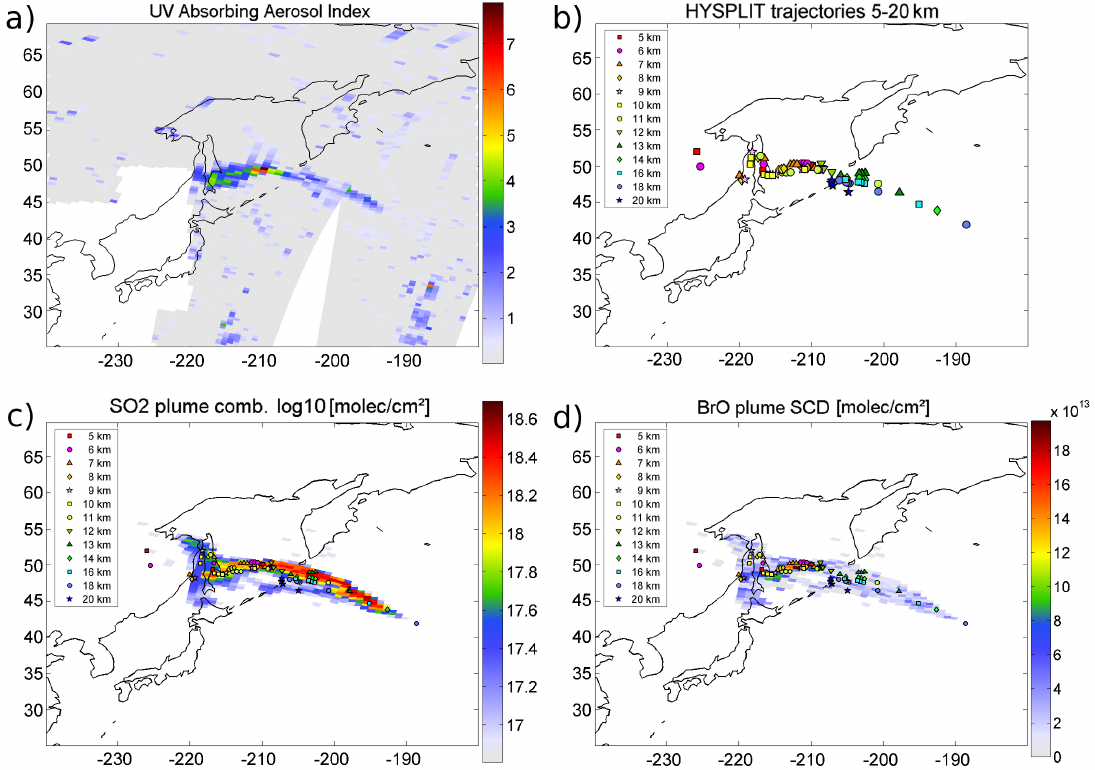
Fig. 14. (a) UV Absorbing Aerosol Index (AAI) for the Sarychev eruption on 15/16 June 2009. Like for BrO, the highest values occur in the western part of the plume, indicating an ash-rich explosion in temporal proximity to the satellite measurements. (b) HYSPLIT trajectory endpoints for starting heights between 5 and 20km of the last 5 major explosions during the two days before the GOME-2 measurements took place. The trajectory simulations point out, that the wind changed from western to eastern direction between 11 and 13km with increasing height. (c) Overlap of the volcanic SO 2 plume from the combined retrieval with the trajectory endpoints. (d) Overlap of the BrO 2 SCDs ∗ in the area of the captured SO 2 plume with the trajectory endpoints. Table 3. Categories that were used for the BrO/SO 2 analysis of all detected volcanic